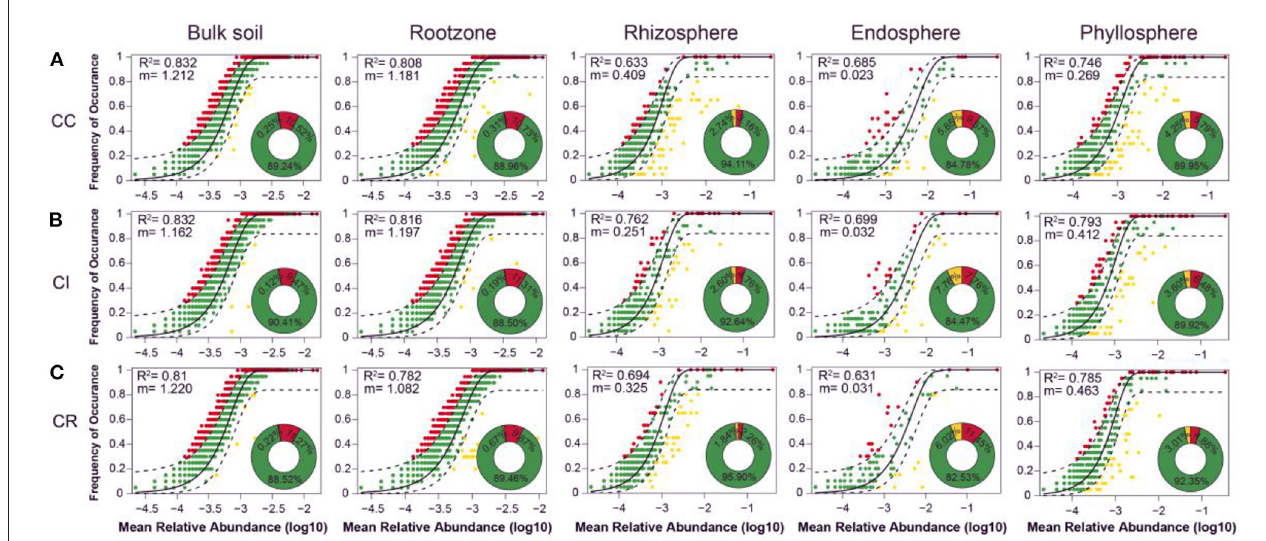
FIGURE 4 | Measurement of bacteria community assembly process of different soil-plant continuum under (A) continuous cropping (CC), (B) intercropping (CI), and (C) crop rotation (CR) systems by dominance test: ASVs that occur more frequently than predicted by the model are shown in red, while those that occur less frequently than predicted are shown in yellow. ASVs that occur within prediction are shown in green. Dashed lines represent 95% confidence intervals around the model prediction (black